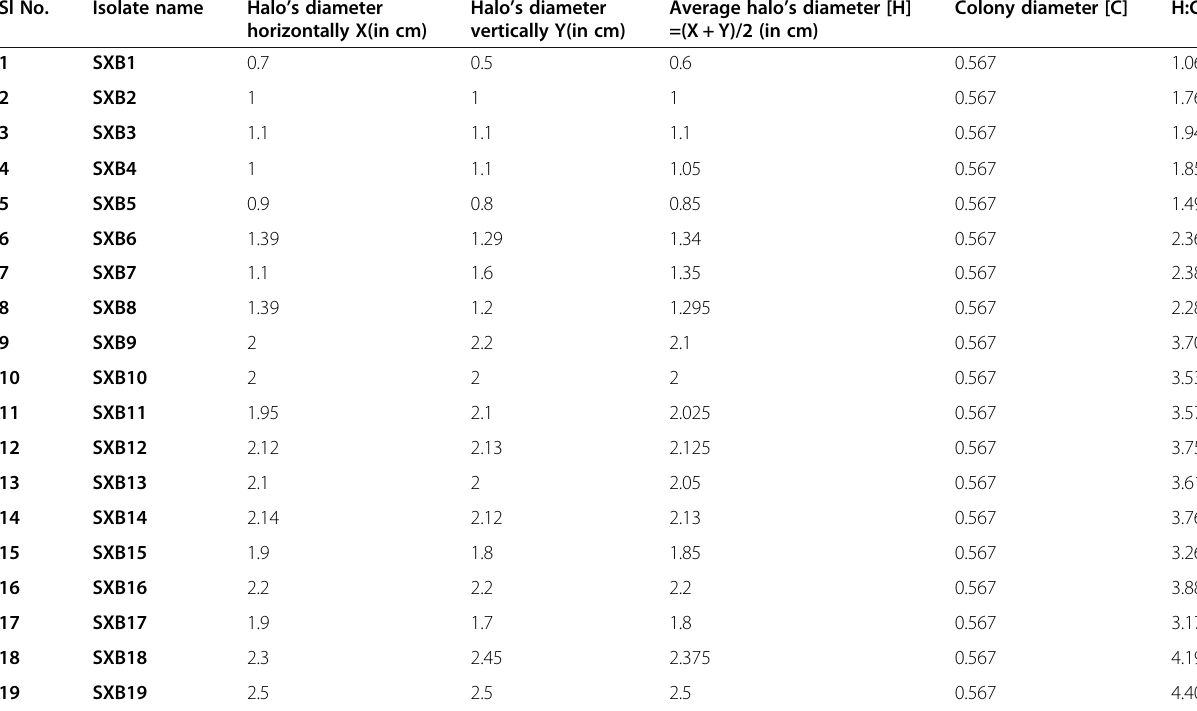
Table 2 Xylan degrading activity of different isolated bacterial strains based on the measurement of xylan hydrolyzing zone Sl No.